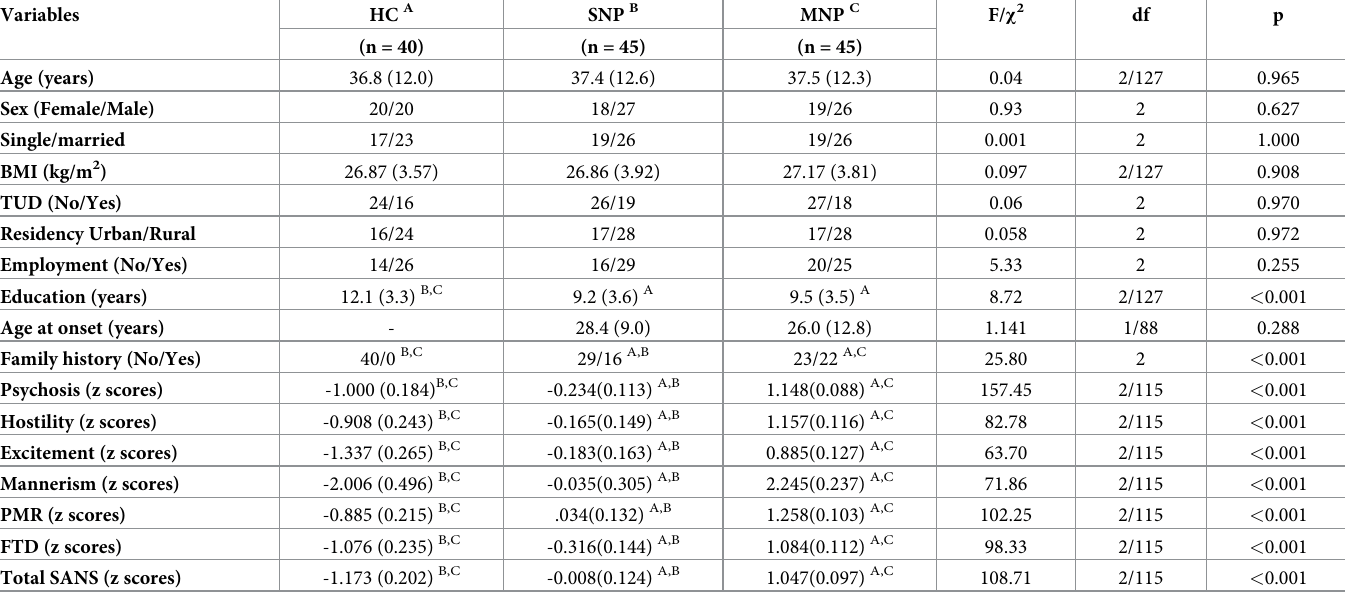
Table 1. Sociodemographic and clinical data of healthy controls (HC) and schizophrenia patients divided into those with major neurocognitive (MNP) versus sim- ple neurocognitive (SNP)